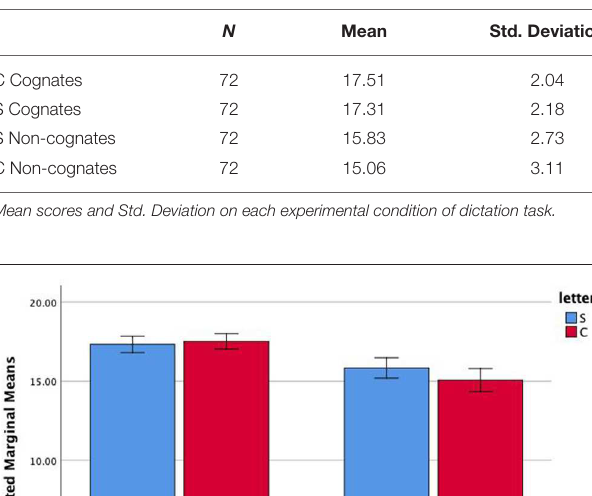
FIGURE 1 | Scatterplot of DELE scores and dictation task total scores.